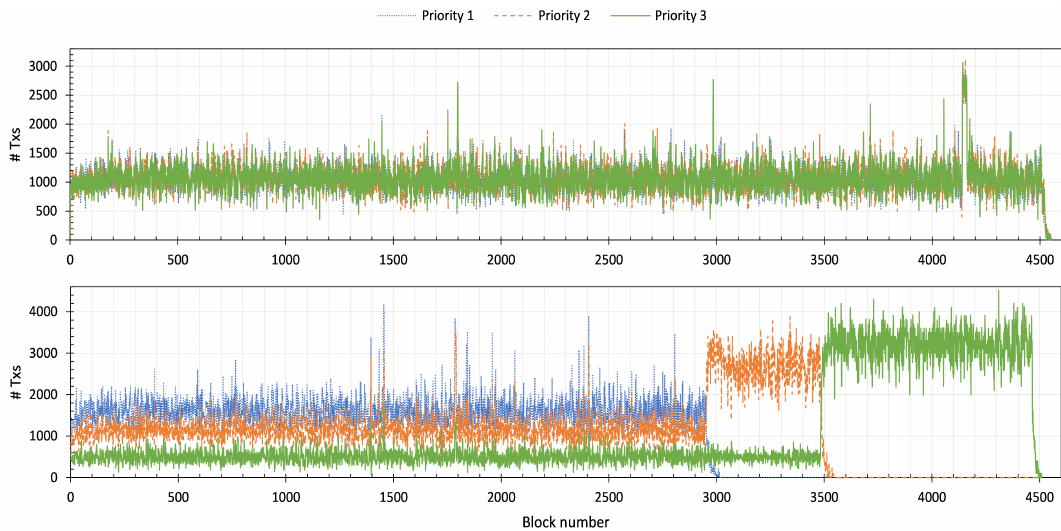
Figure 11. The comparison of the recorded number of transactions (txs) per block for each of the priority type in the Core Engine; without priority ( top ), with priority mechanism ( bottom